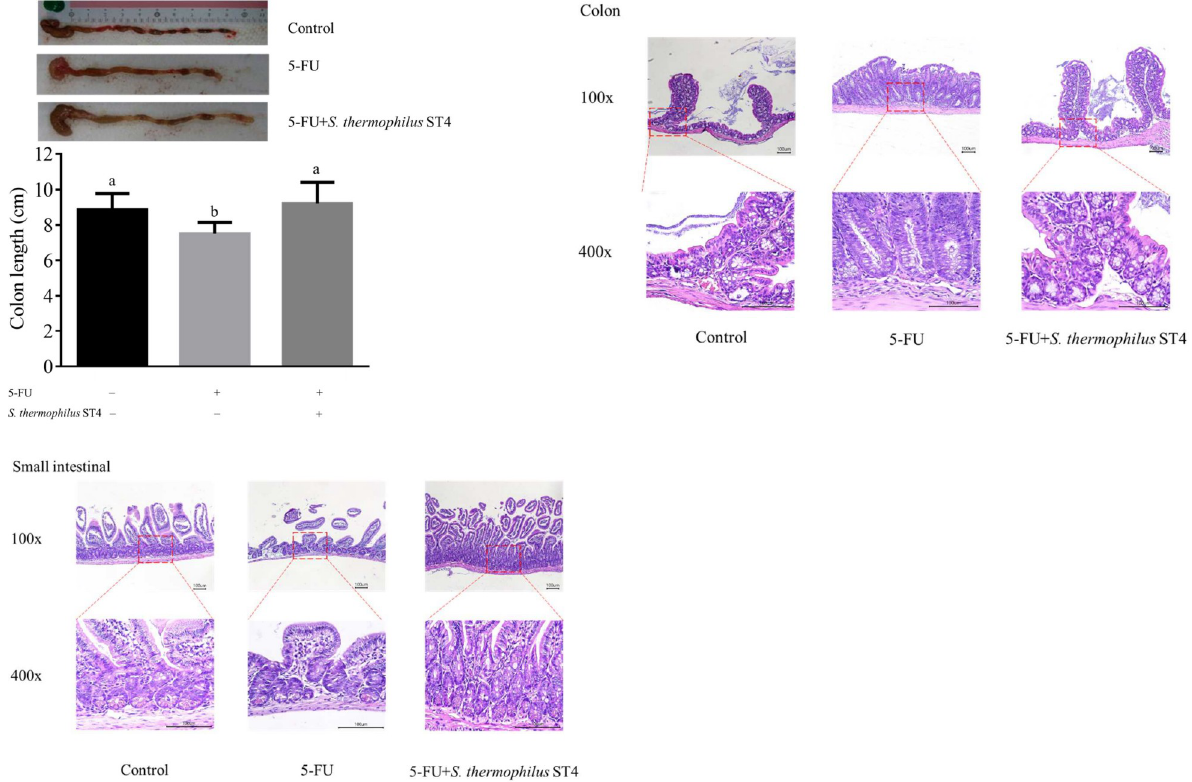
Fig 2. Histopathological examination of 5-FU-induced intestinal mucositis with or without S . thermophilus ST4 treatment. Three groups of mice as indicated were sacrificed according to the experiment design subjected for measuring (A) colon length and (B and C) for H&E staining of the small intestine and colon after excised, sectioned, and then stained, respectively. The representative images (100X and 400X magnifications) of each group are presented. Data are present as mean ± SD. The data with different superscripted letters are significantly different based on the one-way ANOVA ( p <